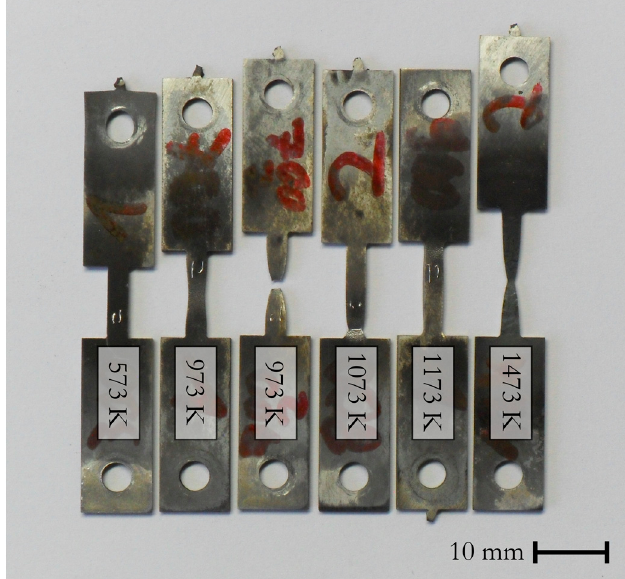
Figure 2. Some specimens after the hot tensile test in the dilatometer.